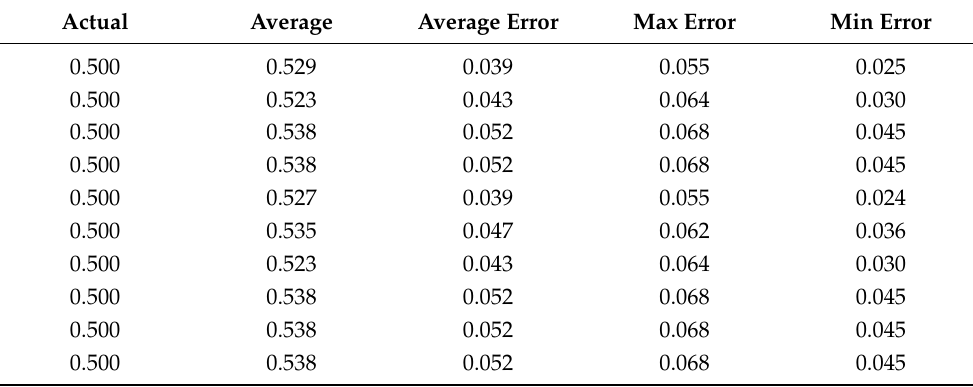
Table A3. Set 1, trials 1–10 data (all 0.5 PR values).